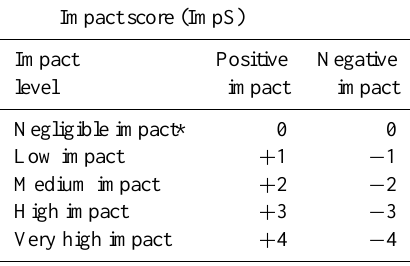
Table 2. A sample of qualitative impacts scoring